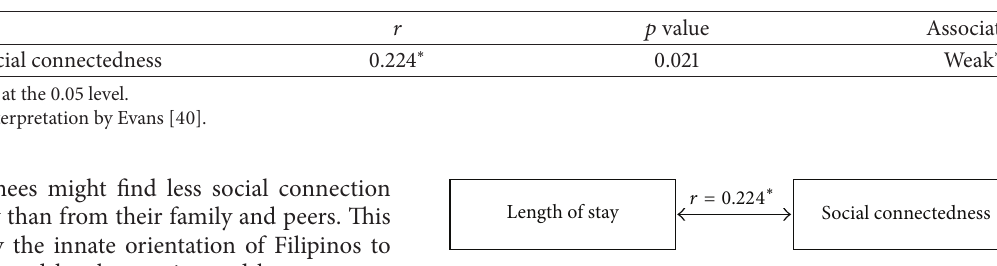
Figure 1: Resulted association between the quantitative